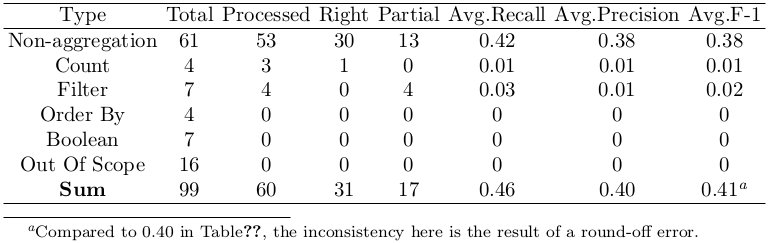
Table from the paper: A Graph Traversal Based Approach to Answer Non-Aggregation Questions Over DBpedia
Table text:
Type
TotalProcessedRightPartialAvg.RecallAvg.PrecisionAvg.F-1
Non-aggregation
61
53
30
13
0.42
0.38
0.38
Count
4
3
1
0
0.01
0.01
0.01
Filter
7
4
0
4
0.03
0.01
0.02
OrderBy
4
0
0
0
0
0
0
Boolean
7
0
0
0
0
0
0
OutOfScope
16
0
0
0
0
0
0
Sum
99
60
31
17
0.46
0.40
0.41 a
a Compared to 0.40 in Table??, the inconsistency here is the result of a round-oﬀ error.